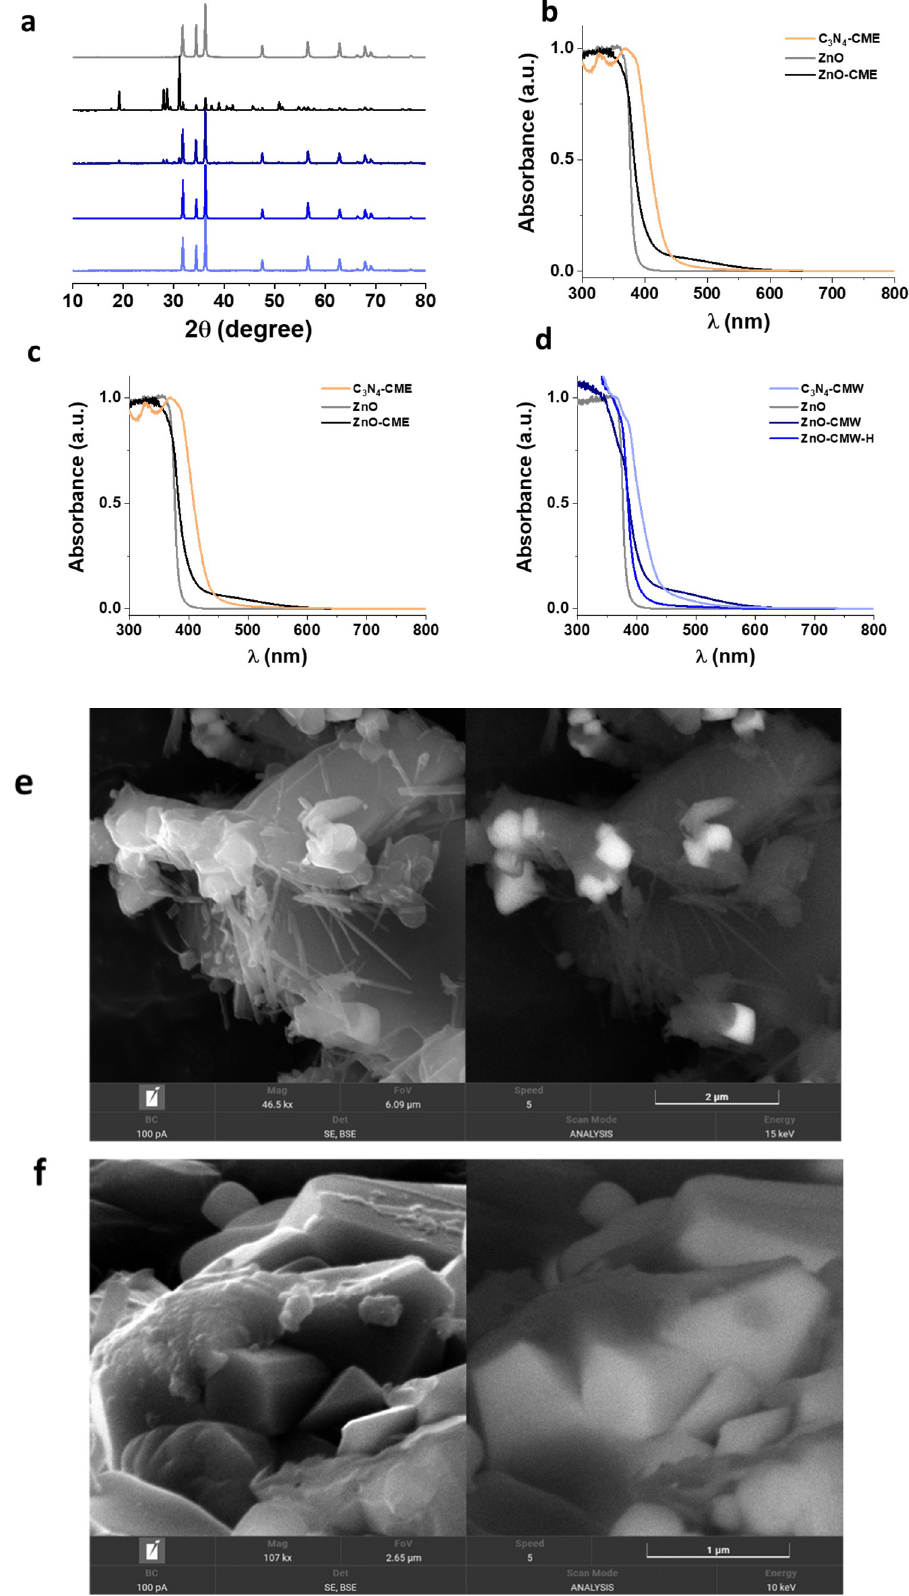
Figure 3. ( a ) XRPD pattern, ( b – d ) DRS-UV spectra and FESEM images (secondary electrons on the left and backscattered electrons on the right) of ( e ) ZnO-CME and ( f ) ZnO-CMW heterojunctions. In an attempt to avoid the observed impurities induced by the unreacted supramolecular complexes, we introduced a hydrothermal step (175°C for 16 hours) before the final calcination treatment in air for the ZnO-CMW sample, now named ZnO- CMW_H. Correspondingly, in the XRPD pattern of hydrothermally treated ZnO- CMW_H, the reflections for the impurities disappeared, and only those related to the ZnO phase are identifiable. Accordingly, hydrothermal treatment by means of the high pressure employed is able to stabilize the organic complex, promoting the complexation of melamine and cyanuric acid in an ordered arrangement of the two monomers, now held together by a greater number of hydrogen bonds and allowing for the net stabilization of the structure [34]. An additional general feature can be derived by analyzing these patterns: the different relative ratio intensities of the three main reflections of ZnO phases (between 2 θ values of 30° and 40°) in the sample grown simultaneously to the carbon nitrate phase compared to pristine ZnO are a clear indication of a certain preferential growth direction for ZnO in the presence of the extra phase, where the nature of the precursor of the latter also induces a guiding effect, tailoring the nanoparticle geometry and aspect ratio. The absence of C 3 N 4 crystallographic peaks in the combined samples is due to different reasons: first, the very low mass of C and N nuclei, and second, the formation of needles or, in some cases, of thin sheets that do not allow the formation of a periodic structure detectable by XRD. Moreover, in support of this suggestion, FESEM images reported in Figures 3e,3f highlight the morphological differences in the ZnO-CMW and ZnO-CME samples for both the ZnO and C 3 N 4 phases of the mixed materials: while ZnO-